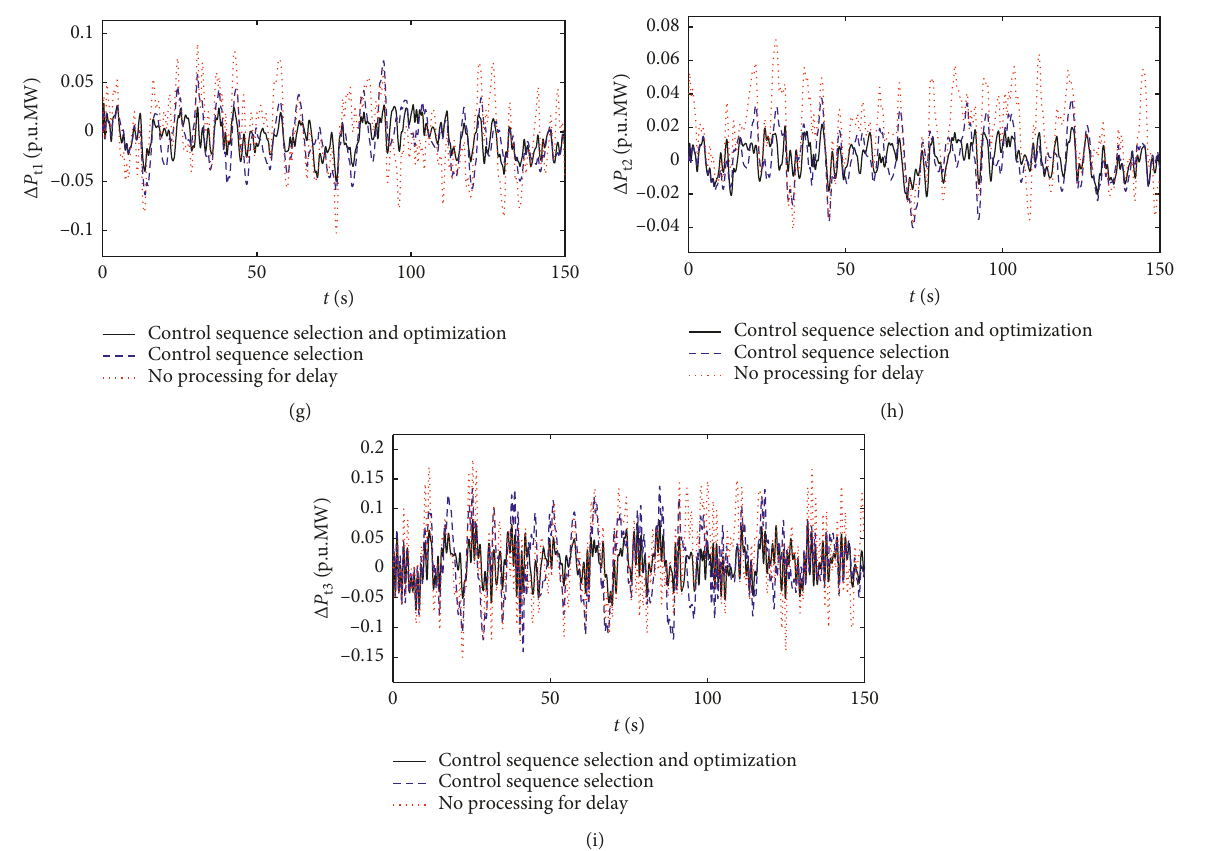
Figure 10: Response curves under random signal. (a) ACE 1 response curve. (b) ACE 2 response curve. (c) ACE 3 response curve. (d) Δ f 1 response curve. (e) Δ f 2 response curve. (f) Δ f 3 response curve. (g) Δ P t1 response curve. (h) Δ P t2 response curve. (i) Δ P t3 response